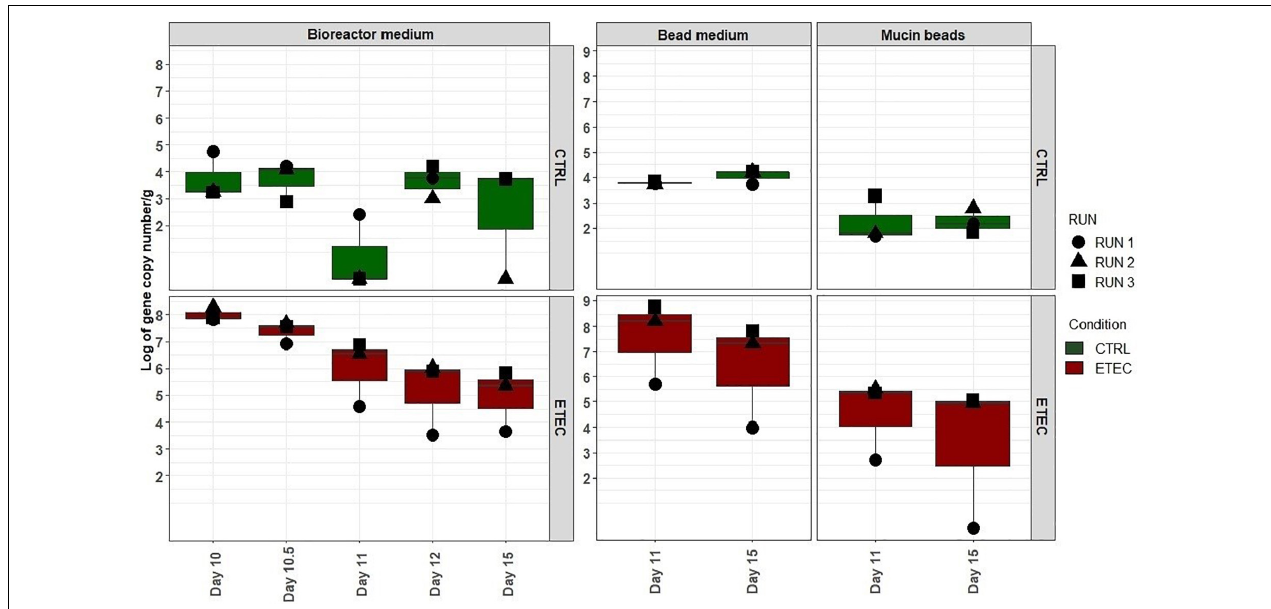
FIGURE 8 | Quantification of the ETEC LT gene in the MPigut-IVM by qPCR for the runs #1, 2, and 3 in the CTRL and ETEC conditions ( n = 3).